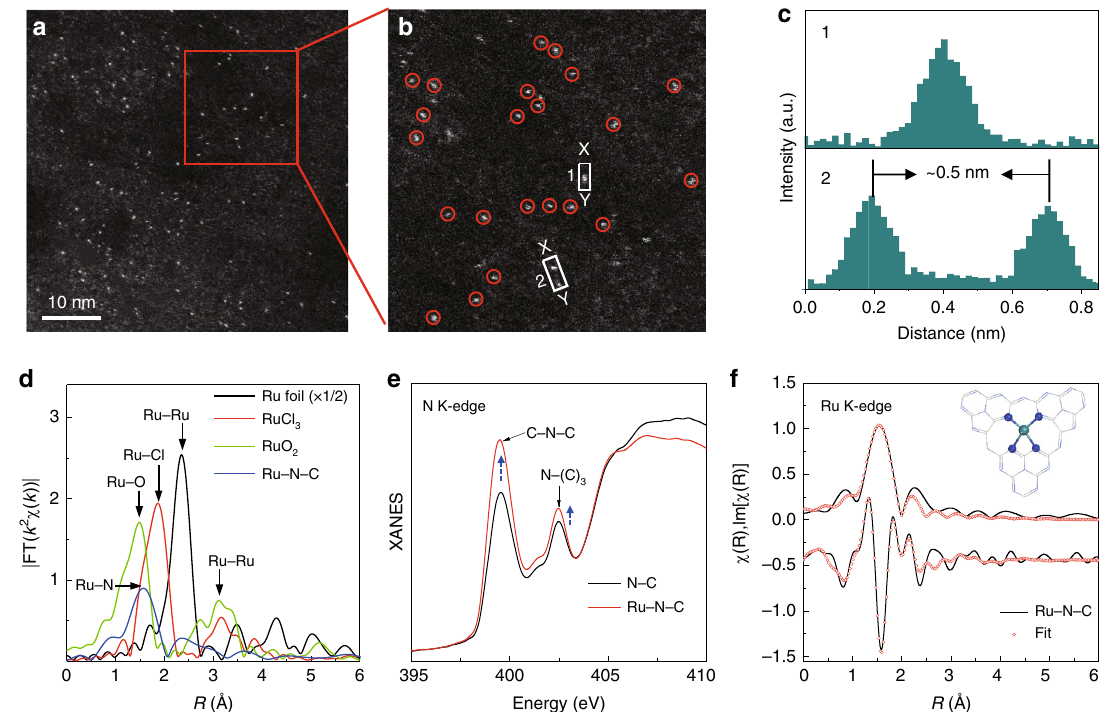
Fig. 1 Structural characterizations of Ru-N-C. a Representative HAADF-STEM image of Ru-N-C catalyst. b Magni fi ed HAADF-STEM image of Ru-N-C form the highlighted area of ( a ), showing that the only bright dots corresponding to isolated Ru atoms exist in Ru-N-C. c Intensity pro fi les along the lines X – Y in ( b ). d The Ru k-edge k 2 -weighted Fourier transform spectra for Ru foil, RuCl 3 , RuO 2 , and Ru-N-C. e N K-edge XANES of pristine N-C and Ru-N-C catalysts. f The R- space curve- fi tting of ex situ Ru-N-C. Top and bottom curves are magnitude and imaginary part, respectively. Insert shows the structure of the Ru site in Ru- N-C. The balls in gray, blue, and light green represent C, N, and Ru atoms,